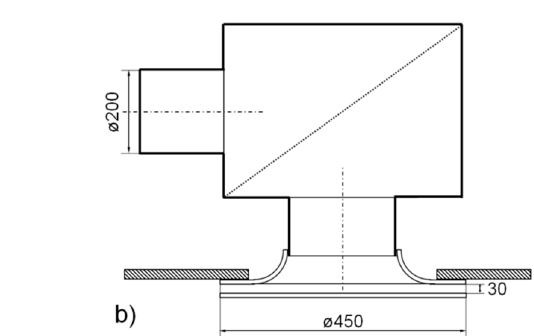
Figure 3b. Multiplying mean speed 𝑈(cid:3365) and the 𝑊(cid:3365) 𝑈(cid:3365)⁄ ratio, the profile of the mean speed 𝑊(cid:3365) was determined. The profile of 𝑊(cid:3365) 𝑈(cid:3365) ⁄ is shown in Figure 3a. (cid:3040)